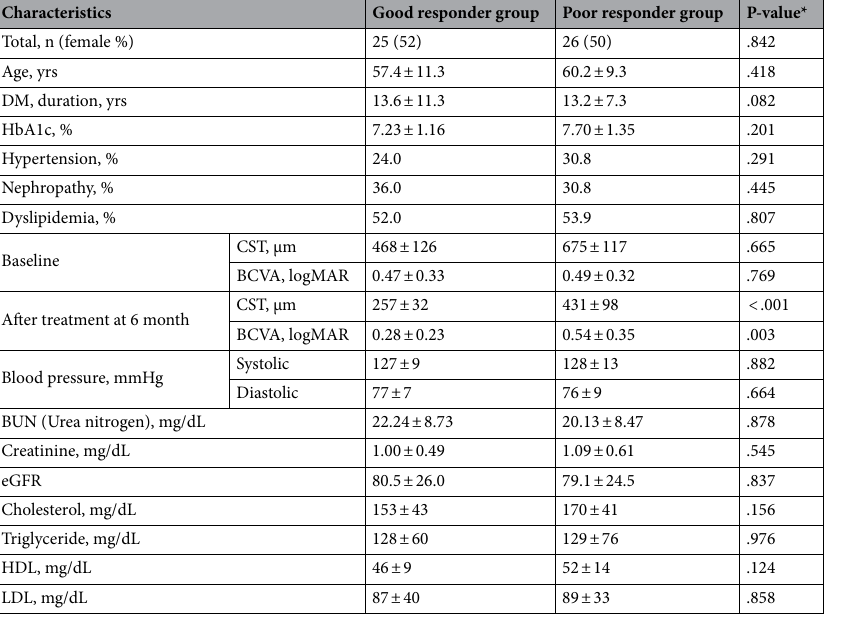
Table 1. Demographic and clinical characteristics of the study subjects. *P-values for the difference between the good and poor responder groups were obtained. DM: diabetes mellitus; CST: central subfield thickness; BCVA: best-corrected visual acuity; BUN, blood urea nitrogen; eGFR: estimated glomerular filtration rate; HDL: high-density lipoprotein; LDL: low-density